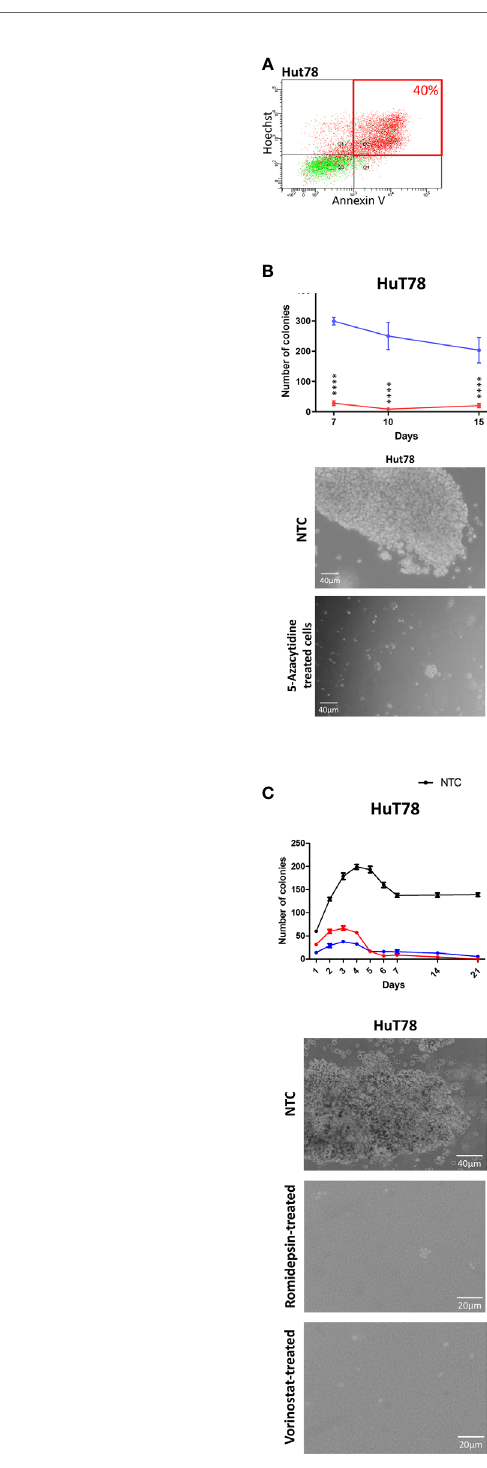
FIGURE 1 | 5-azacytidine, romidepsin and vorinostat treatment in Se ́ zary cells in vitro . (A) Flow cytometry plots showing the apoptosis/necrosis analyses of 5-azacytidine treated cells and displaying the % of late apoptotic cells for HuT78, L2 and L4 (40%, 35% and 72% respectively). (B) Graphs showing the number of colonies per well in NTC (blue) and 5-azacytidine TC (red); and microscopic captures of the colonies observed in NTC (upper images) and after 5-azacytidine treatment (lower images), of HuT78, L2 and L4 Se ́ zary celllines. (C) Colonies formation in HuT78, L2 and L4 without treatment (NTC, black line) or after 48h of romidepsin (blue line) or vorinostat (red line); and microscopic captures of the colonies observed in NTC ( fi rst line) and after treatment (second and third lines), for HuT78, L2 and L4 Se ́ zary cell